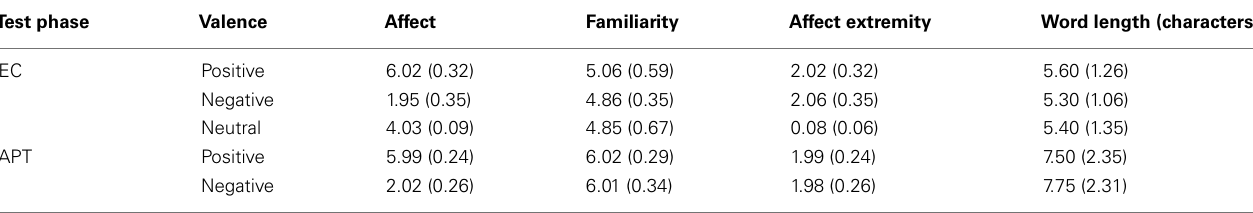
Table 1 | Means (SD) for affect, affect extremity, familiarity, and word length of words used per valence category. Test